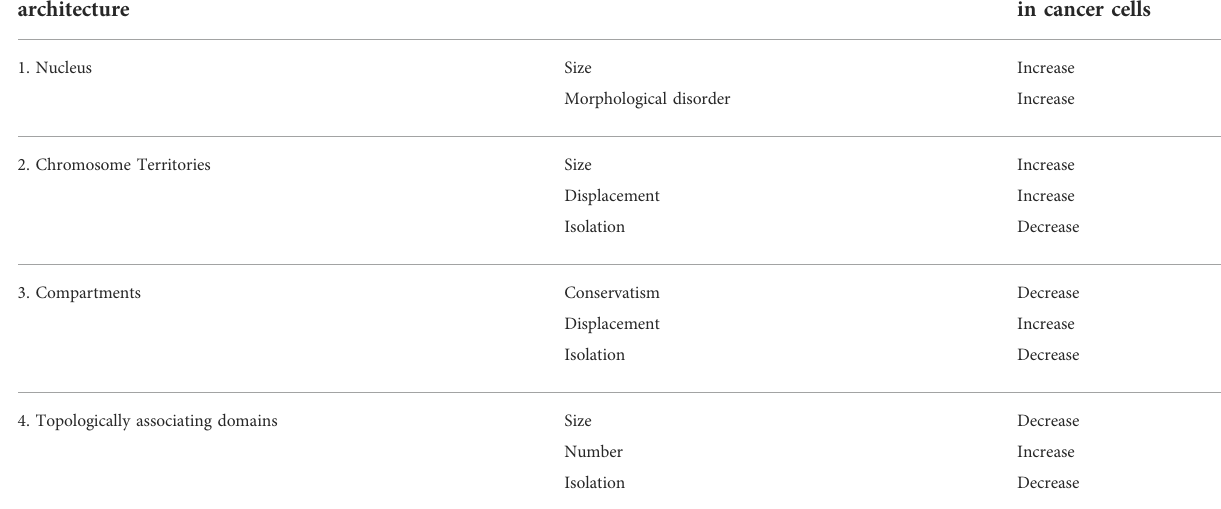
TABLE 1 Chromatin architecture alterations in